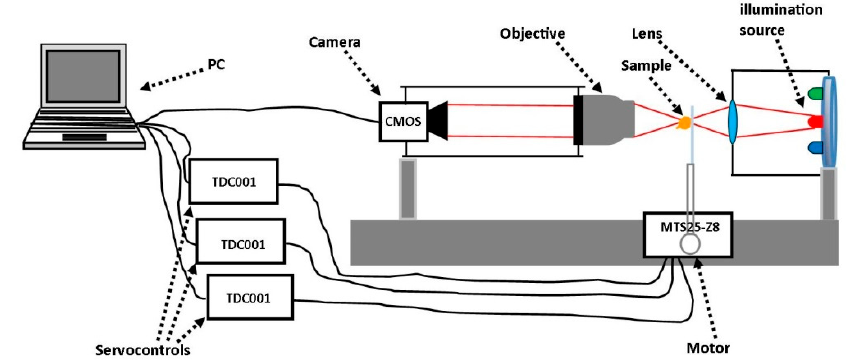
Figure 1. Set-up of the microscope constructed for automated image acquisition. The red lines illustrate the beam path interacting with the